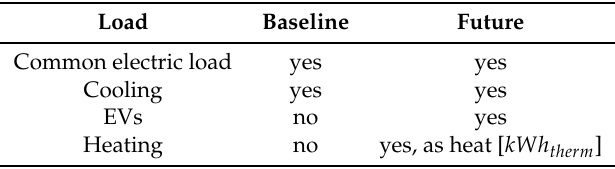
Table 1. Overview of electric consumption in the scenarios.